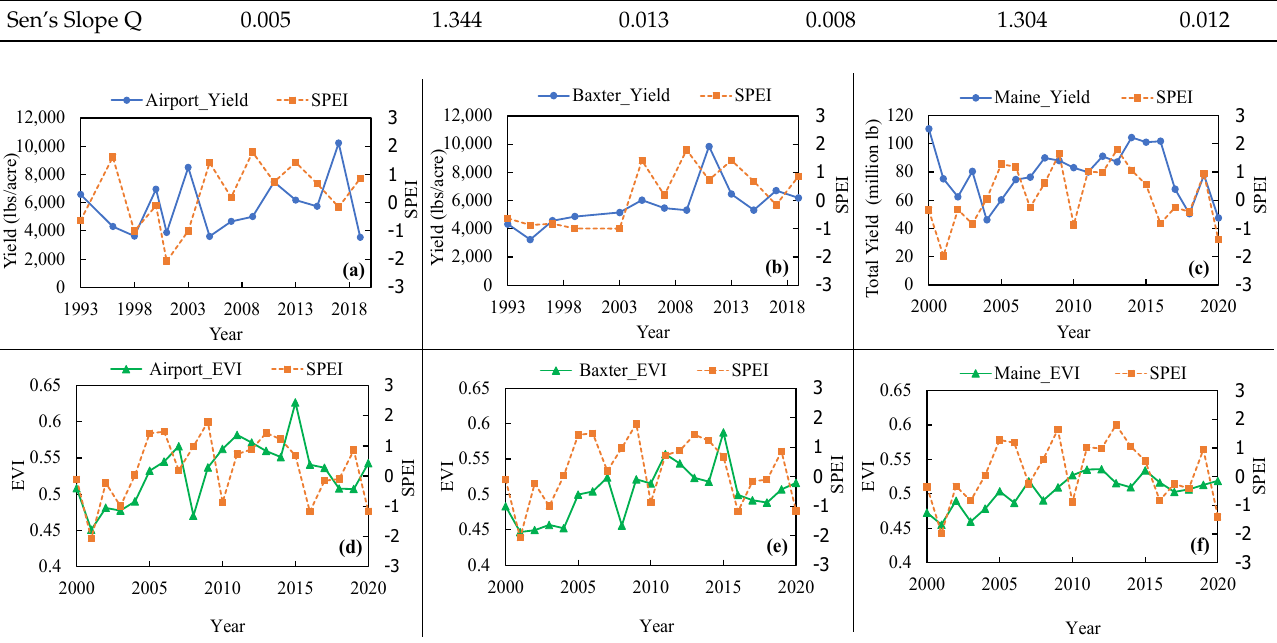
Figure 5. ( a , d ) Historical values of yield and SPEI (( a ): 1993–2019), and of the EVI and SPEI (( d ): 2000–2020) for the Airport (irrigated) field, Deblois, ME. ( b , e ) Historical values of yield and SPEI (( b ): 1993–2019), and in the EVI and SPEI (( e ): 2000–2020) for the Baxter (non-irrigated) field, Deblois, ME. ( c , f ) Historical values of yield and SPEI (( c ): 2000–2020), and in the EVI and SPEI (( f ): 2000–2020) for the major wild blueberry production region in Maine. Here, orange dashed lines indicate SPEI, blue solid lines indicate yield, green solid lines indicate EVI. Here, SPEI refers to SPEI_6 of September. It represents the SPEI of the growing season (April–September) and indicates water conditions. A positive SPEI value represents wet conditions, while a negative SPEI value indicates dry